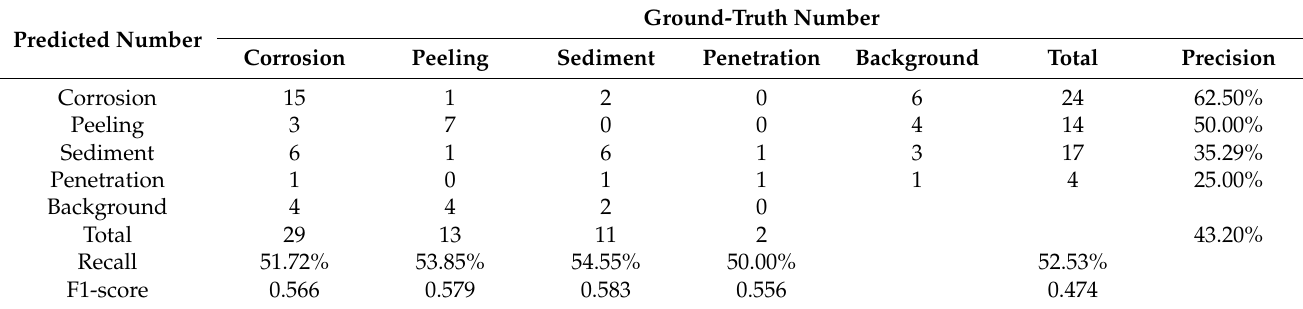
Table 7. Defect detection result without data